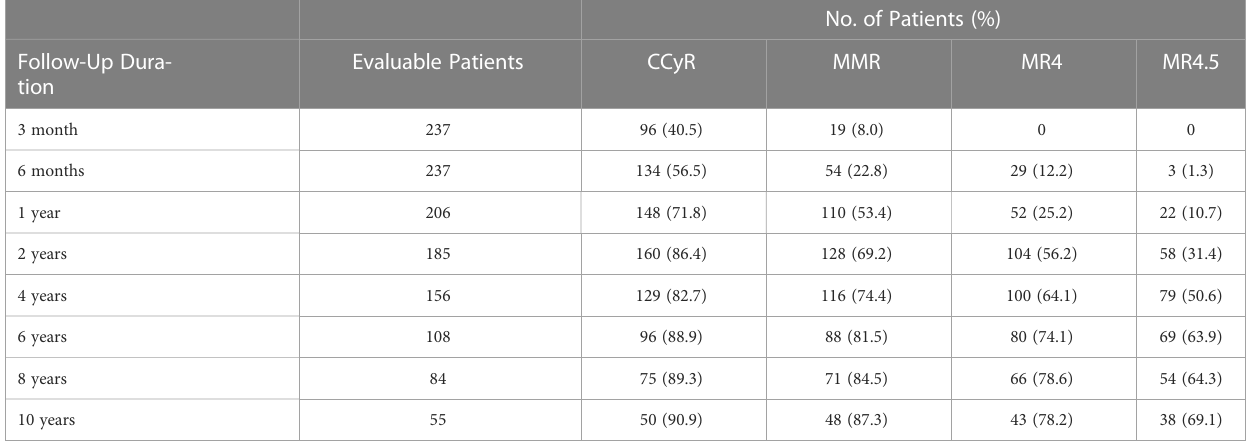
TABLE 2 Clinical responses to imatinib over time.